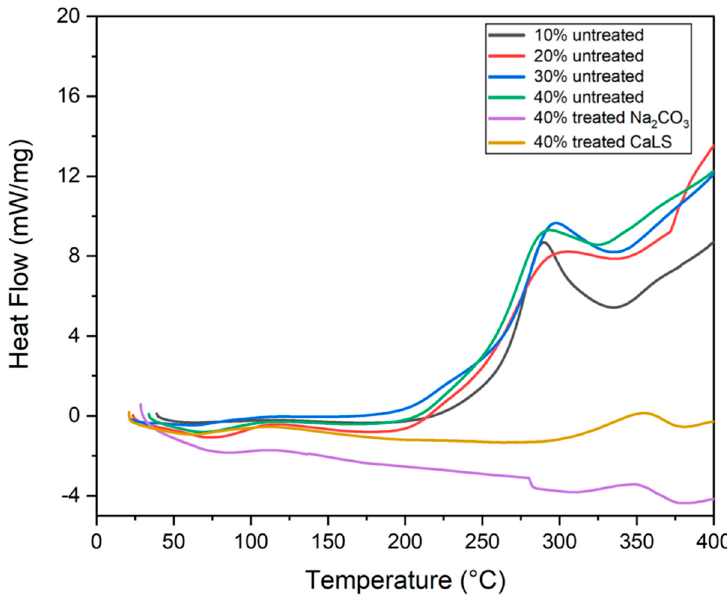
Figure 8. DSC curves for untreated and treated TVF composites.